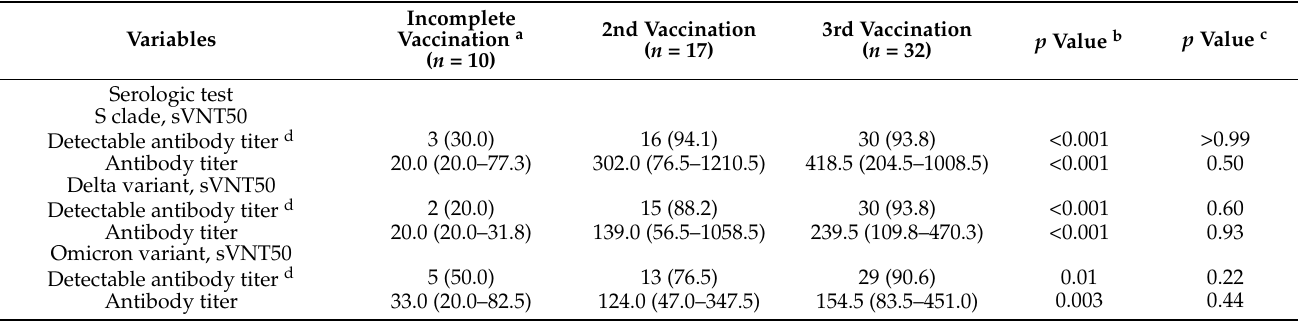
Table 2. Comparison of serologic results in each cohort of patients aged ≥ 60 years according to their vaccination history before SARS-CoV-2 infection.